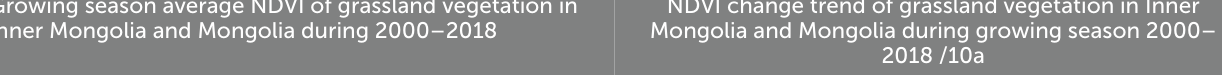
TABLE 1 Comparison of growing season average NDVI and associated trend of grassland vegetation types in Inner Mongolia and Mongolia from 2000 to 2018. Growing season average NDVI of grassland vegetation in Inner Mongolia and Mongolia during 2000–2018